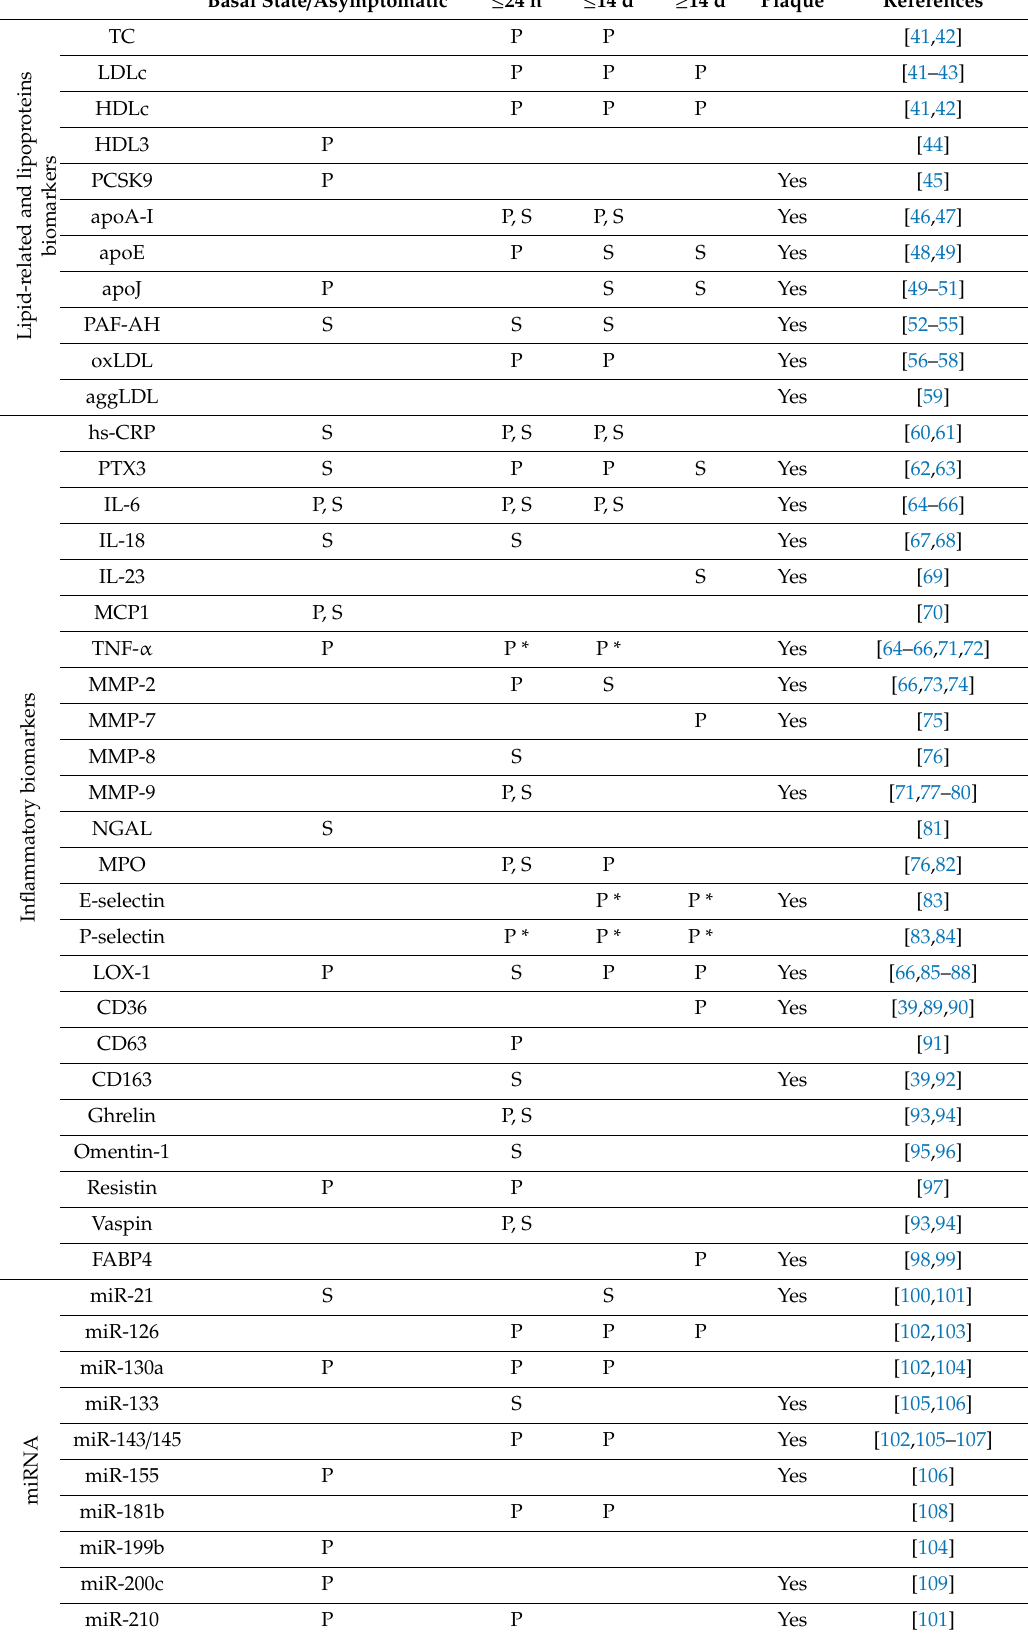
Table 1. Main candidate biomarkers found in plasma / serum and / or plaque from atherothrombotic stroke